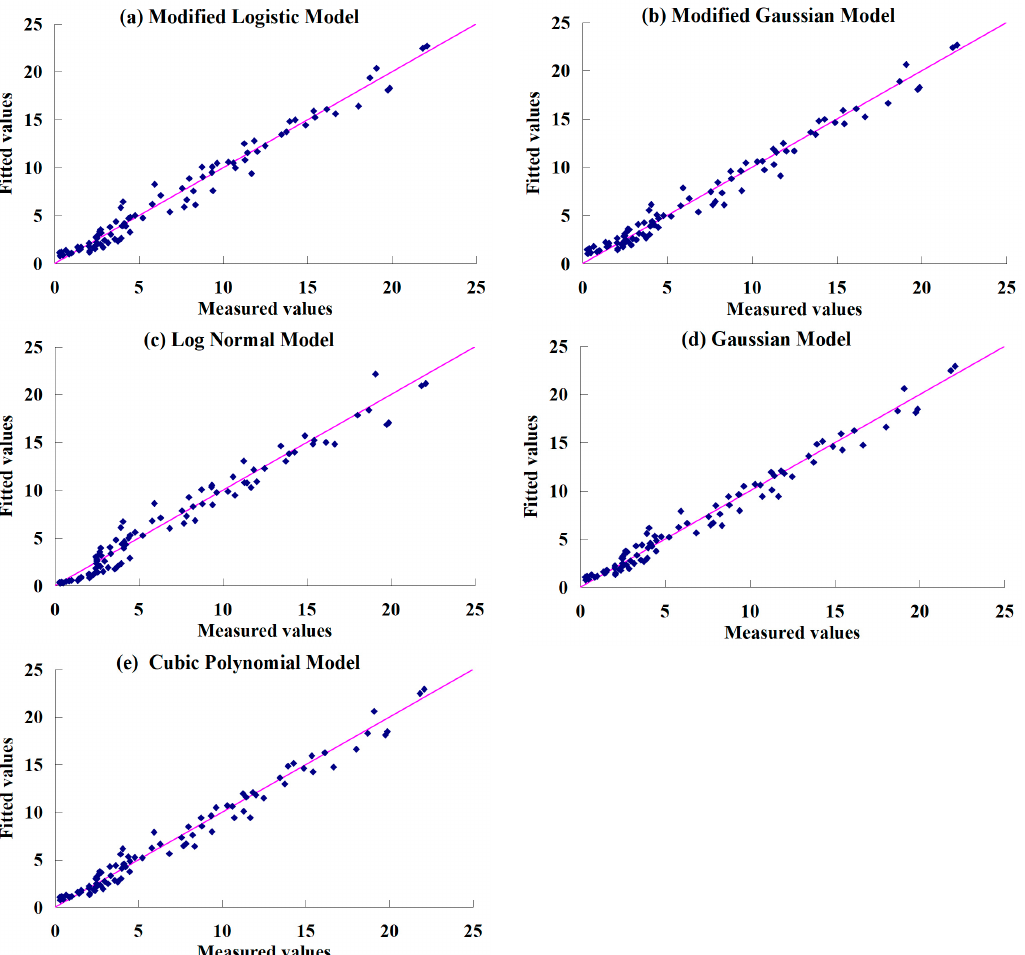
Figure 7. Comparisons of the measured and fitted leaf area index values are calculated by Equation (11) and models in Table 2: ( a ) modified Logistic model; ( b ) modified Gaussian model; ( c ) log-normal model; ( d ) Gaussian model; ( e ) cubic polynomial model.